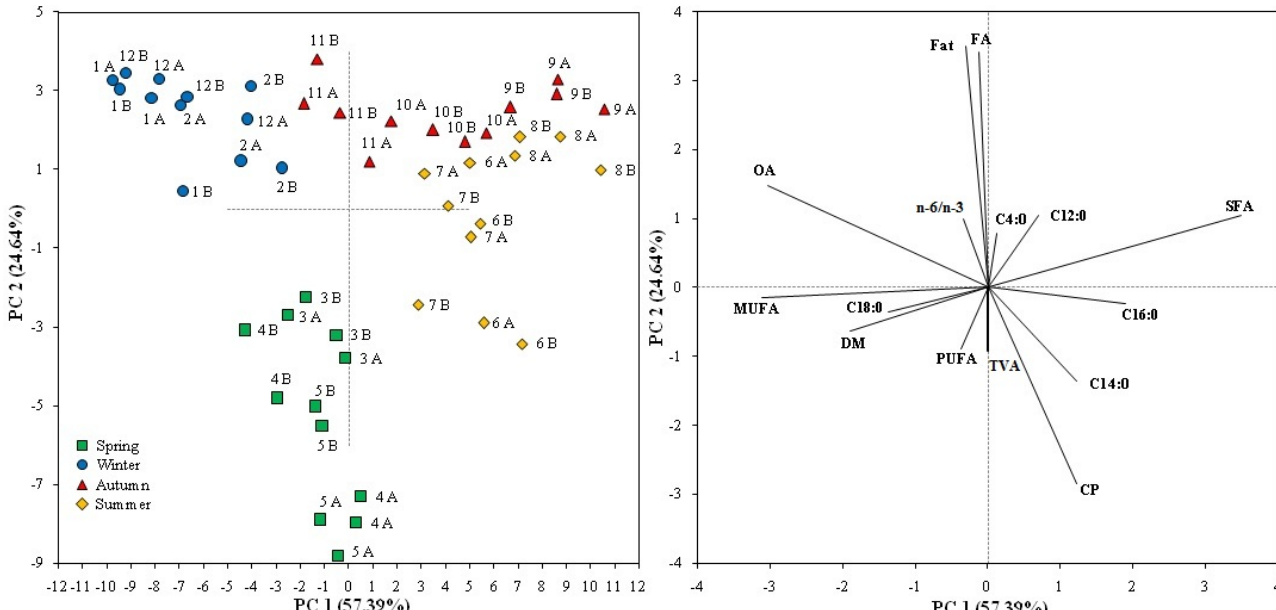
Figure 2. PCA analysis based on chemical traits of milk and cheese and FA composition for production month. The length of each vector is proportional to its contribution to the main components. Abbreviations: DM = dry matter; CP = crude protein; FA = total fatty acids; SFA = saturated fatty acids; MUFA = monounsaturated fatty acids; PUFA = polyunsaturated fatty acids; OA = oleic acid; TVA = trans-vaccenic acid; 1 to 12 = months; A and B = farms.